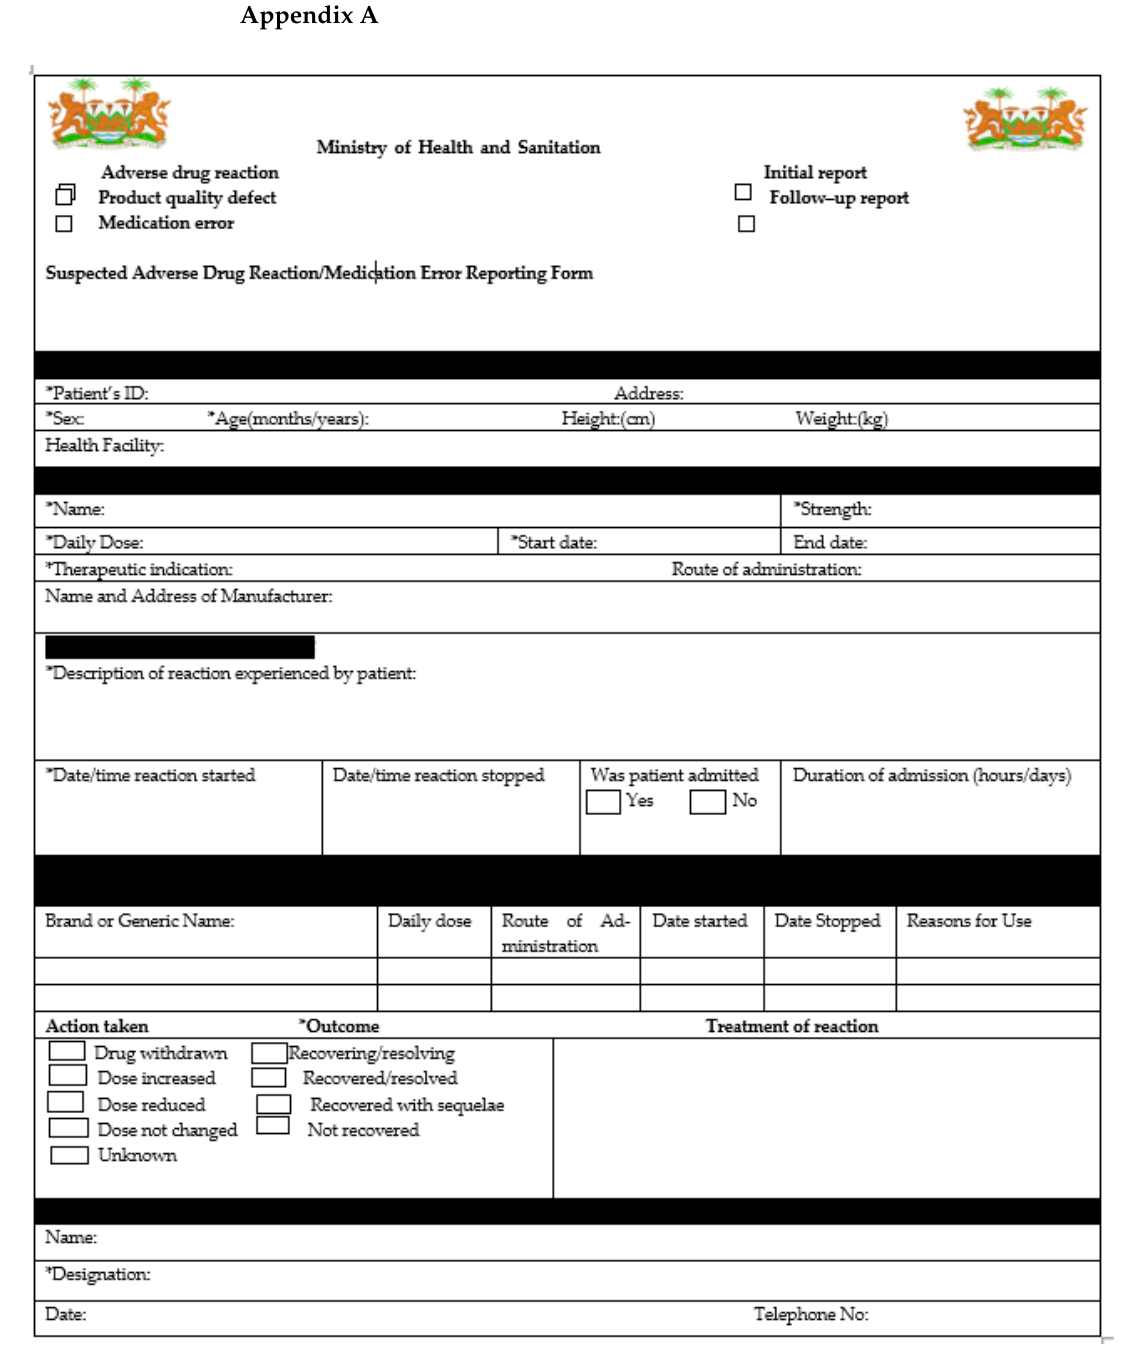
Figure A1. ADR reporting form in Sierra Leone. Note: Fields marked (*.) are mandatory.